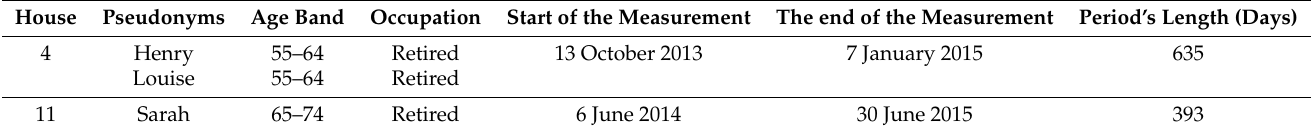
Table 4. The meta-data of house 4 and 11 from the REFIT dataset.